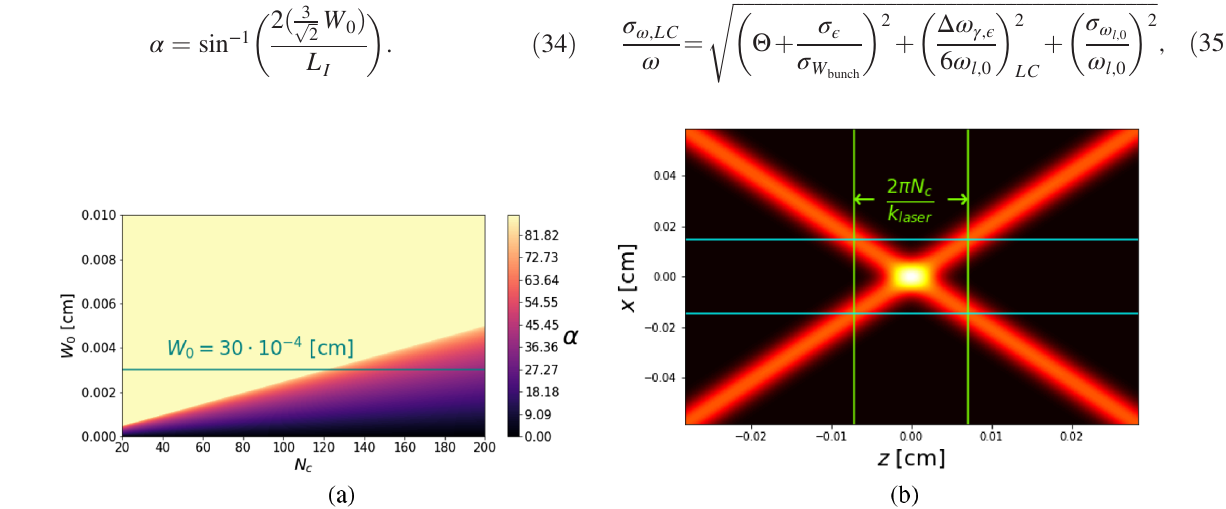
FIG. 4. Possible configuration for LC with ω l; 0 ¼ 1 . 77 × 10 15 [ 1 ] (a) Shows the possible angles as function of N c (proportional to the s interaction length). The blue line indicates the width W 0 ¼ 30 × 10 − 4 ½ cm (cid:2) . The yellow shaded region indicates incompatible sets of parameters.(b) Intensity profile of the two Gaussian beams in the x and z plane.